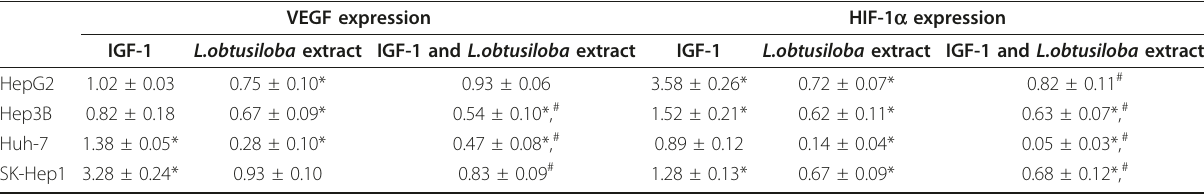
Table 1 Expression of VEGF and HIF-1 a in human HCC cell lines VEGF expression